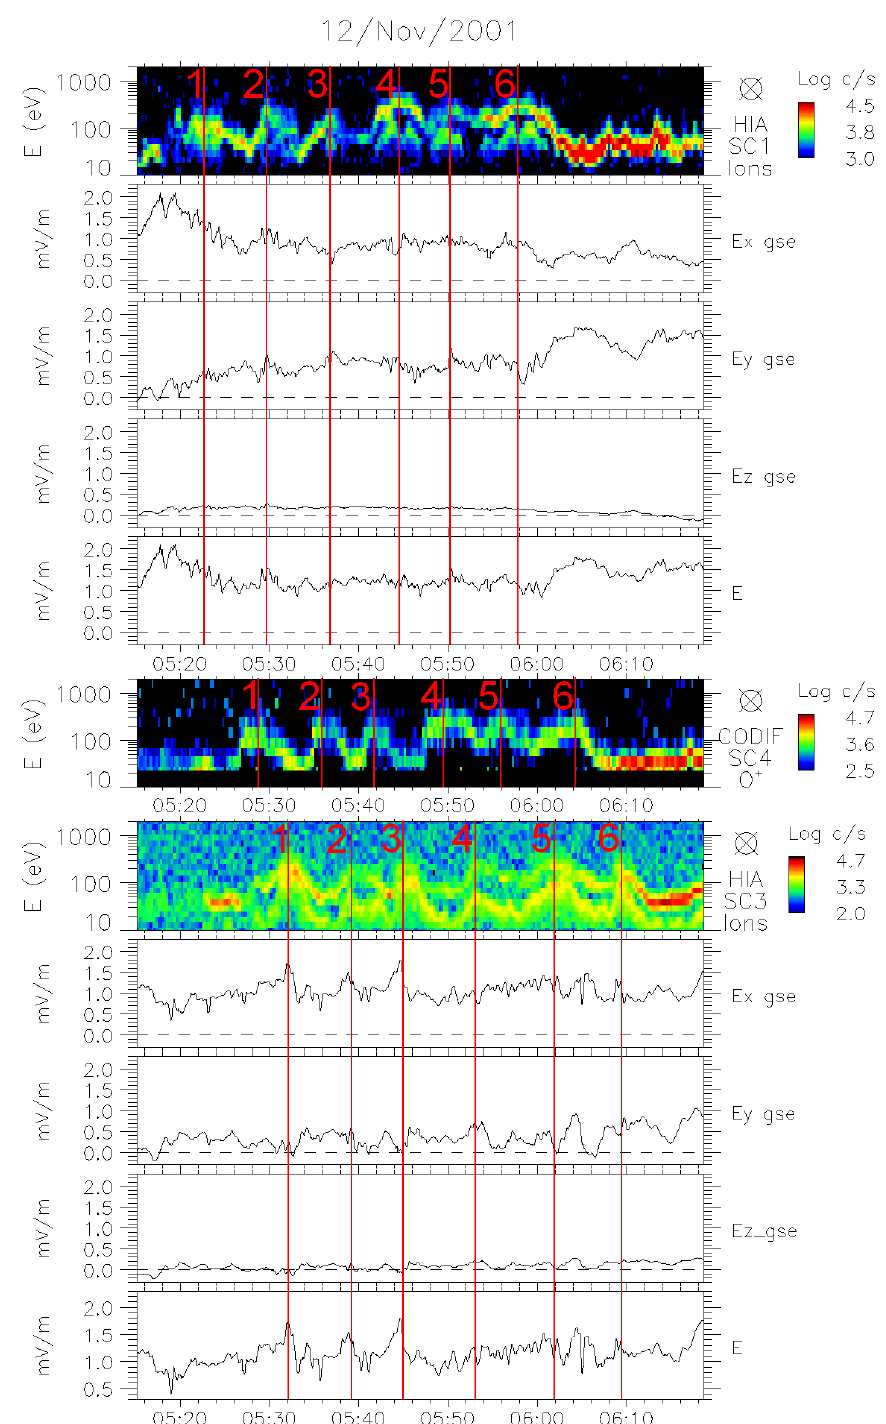
Fig. 3. 12 November 2001. From top to bottom: Energy-time spectrogram from HIA for all ions, spacecraft 1. GSE components and modulus of the convection electric field as given by EDI, spacecraft 1. Energy-time spectrogram from CODIF for O + ions, spacecraft 4. Energy-time spectrogram from HIA for all ions, spacecraft 3. GSE components and modulus of the convection electric field as given by EDI, spacecraft